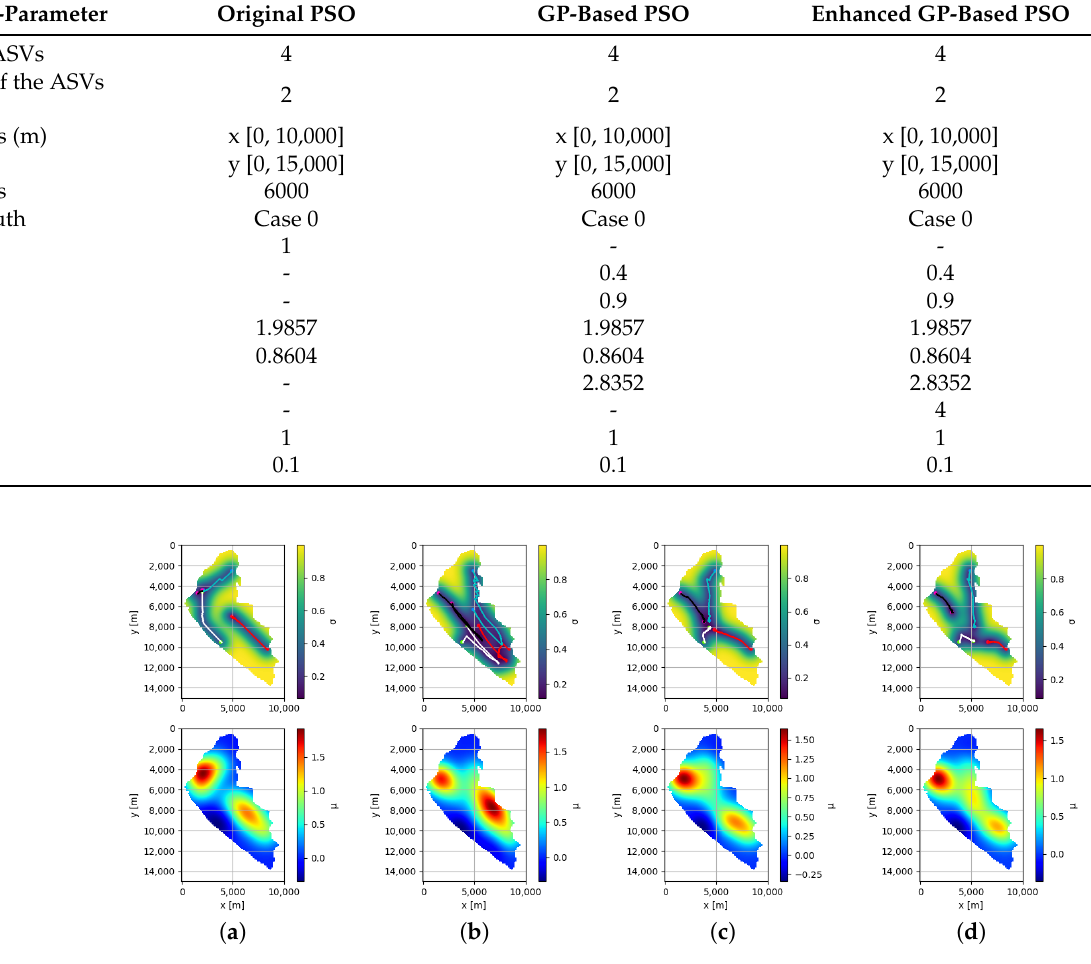
Figure 7. Representation of movements of the ASVs and uncertainty in the exploration of the lake surface (top) and mean of the surrogate model (bottom) using three different algorithms.